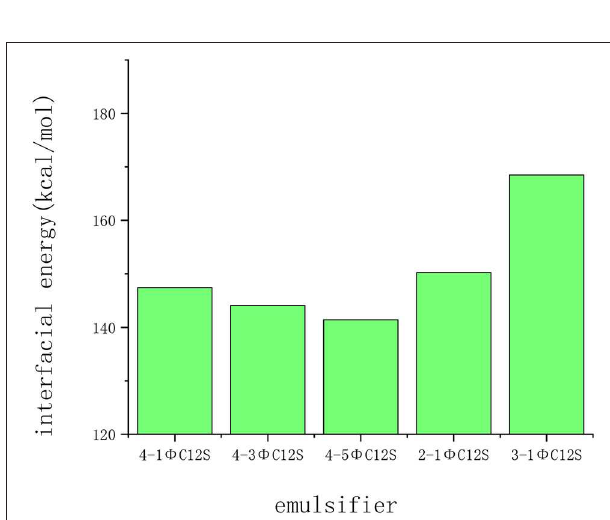
FIGURE 8 | Results of the potential energy calculation for the emulsifier on the CaCO 3 surface.